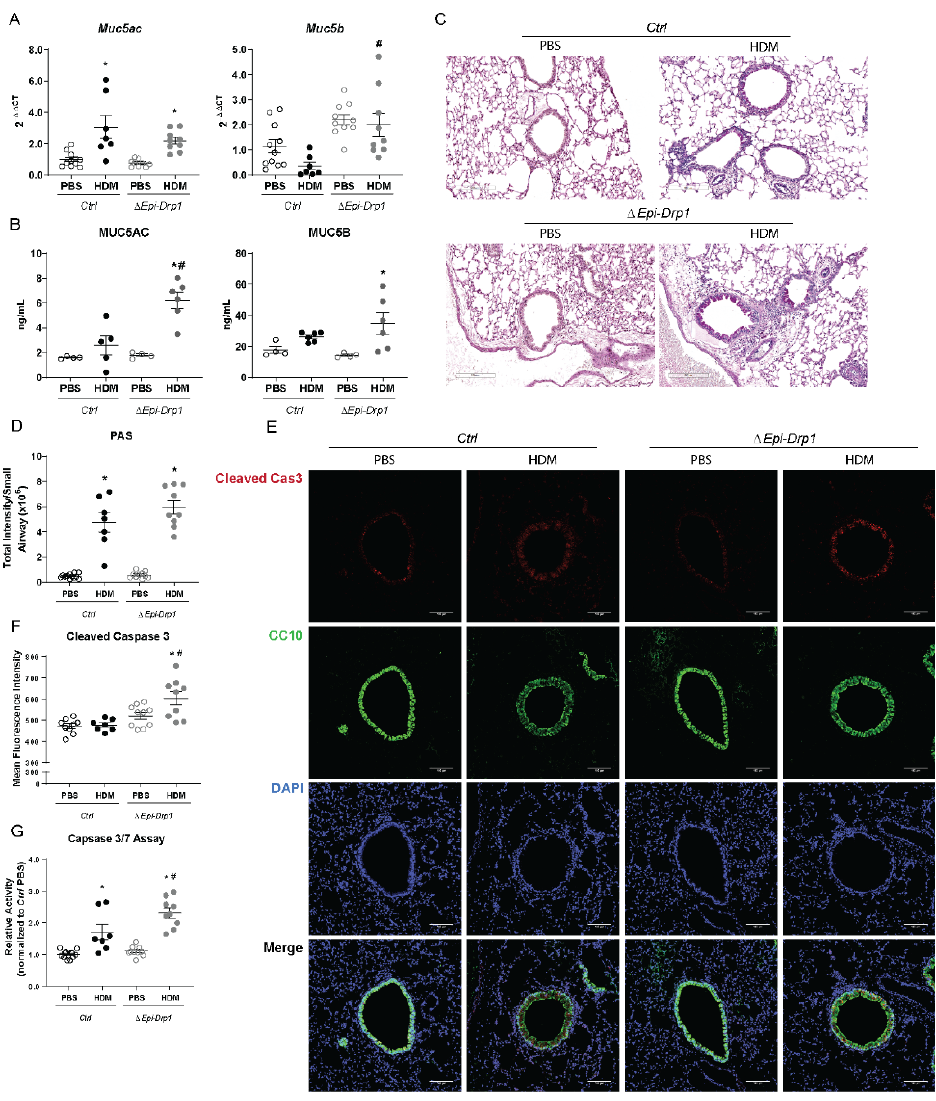
Figure 4. Epithelial specific Drp1 deletion enhances mucin metaplasia and epithelial cell death following HDM exposure. ( A ) RT-qPCR of mucins in whole lung lysates, n = 6–12 mice per group from 2 experiments; ( B ) ELISAs of mucins in the BALF, n = 6–12 mice per group from 2 experiments; ( C ) Representative images of PAS staining in lung tissue sections; ( D ) Quantification of PAS staining, n = 7–12 mice per group from 2 experiments; ( E ) Representative immunofluorescence images of Cleaved Caspase 3 (Cleaved Cas3) and CC10; ( F ) Quantification of mean fluorescence intensity (MFI) of Cleaved Cas3 in immunofluorescence images, n = 7–10 mice per group from 2 experiments; ( G ) Luminescence activity assay of Caspases 3 and 7 (Caspase Glo Assay) in whole lung lysates, n = 7–13 mice per group from 2 experiments; ( A , B , D , F , G ) * p < 0.05 vs. corresponding PBS group, # p < 0.05 vs. Ctrl HDM group. Error bars represent mean ± SEM. ( C ) Scale bars are 200 µ m. ( E ) Scale bars are 100 µ m.